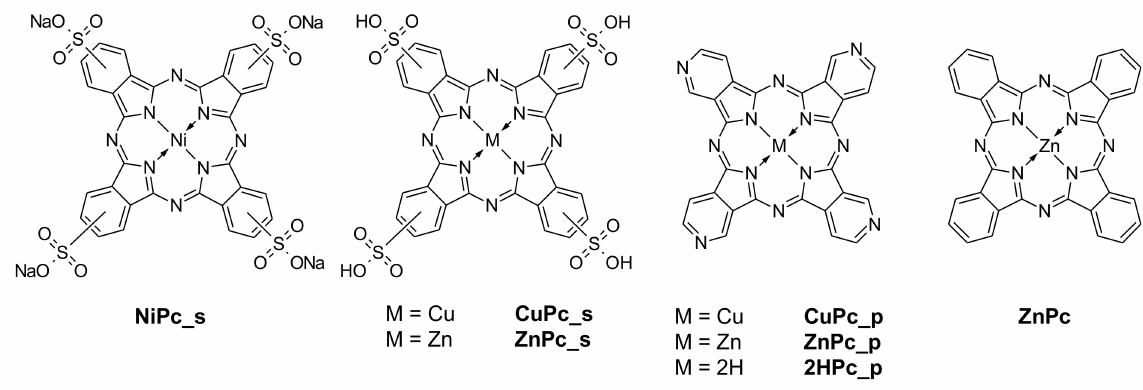
Figure 2. Chemical structures of the phthalocyanine derivatives used in this